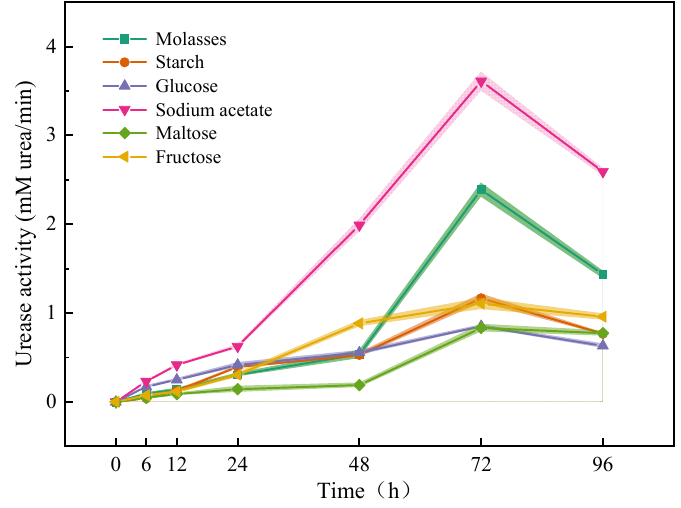
Figure 3. Effect of different carbon sources on urease activity of samples (shadows represent the range of error).